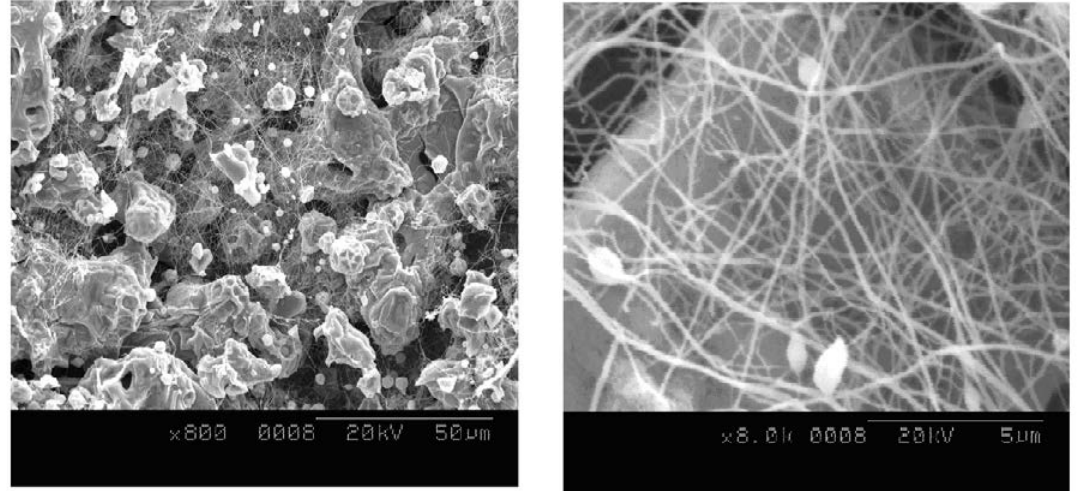
Figure 3. Scanning electron microscope (SEM) photographs of PVP/Ni acetate composite fibers: at low magnification (left), and at high magnification (right).